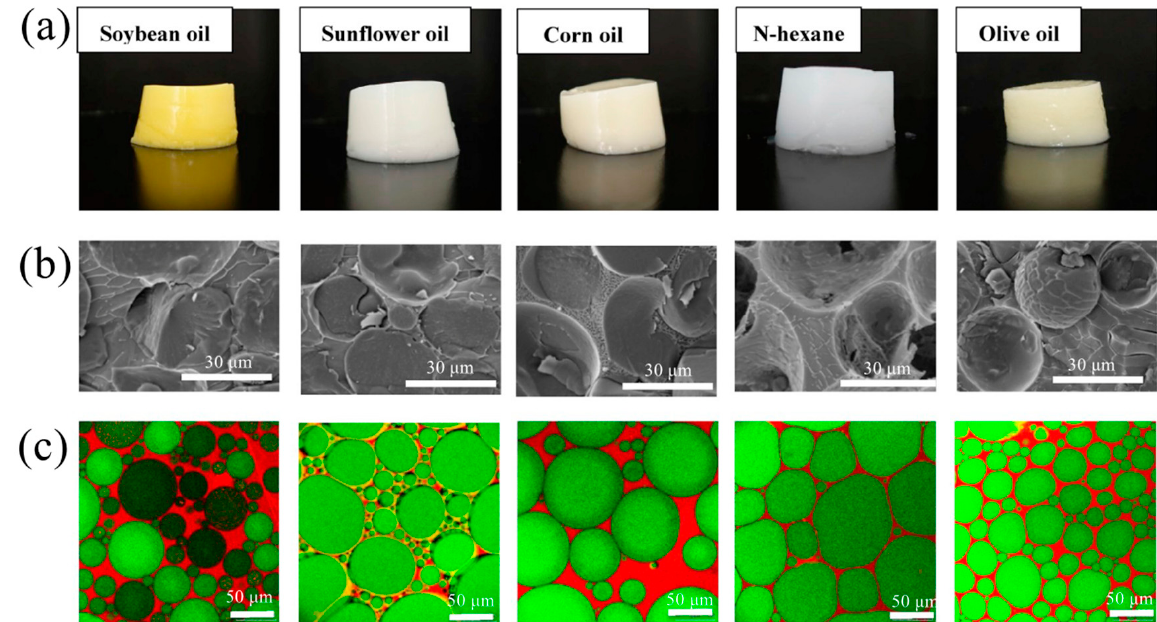
Figure 4. Characterization of the appearance of droplets of Pickering emulsions constructed with different oil phases: ( a ) appearance; ( b ) field emission electron microscopy; ( c ) CLSM. Adapted from [52] with permission from Elsevier Ltd, 2023.